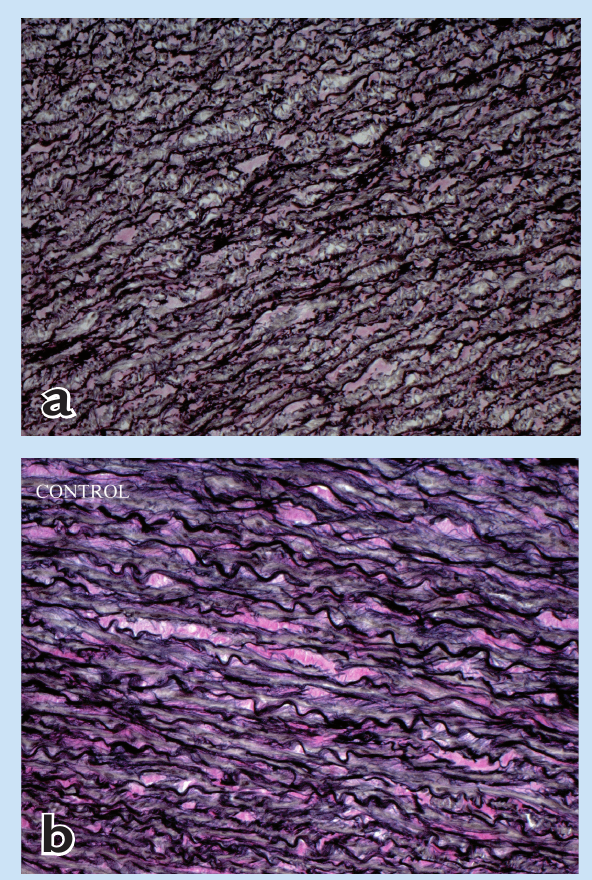
Figs. 6a (patient) and 6b (control) (microscopy). Microscopic specimen of aortic wall using an Elastic Von Gieson (EVG) stain, showing irregular fragmented intimal and medial elastin fibres, relative to an age-matched